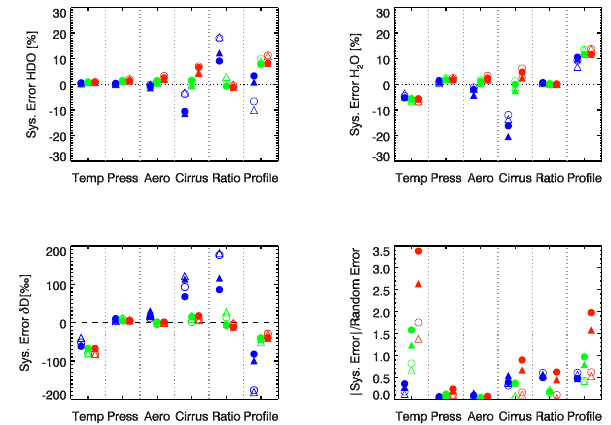
H. Boesch et al.: HDO/H 2 O ratio retrievals from GOSAT 13 Fig. 3. Column averaging kernel of the H 2 O and HDO retrievals (left) and cross dependence between the H 2 O and HDO retrievals given by the non-diagonal elements of the averaging kernel matrix (right). The solid lines are for conifer, dashed lines for desert and the dotted lines for 5% albedo. The thick line is for SZA of 30 (cid:14) and the thin line for 60 (cid:14) .